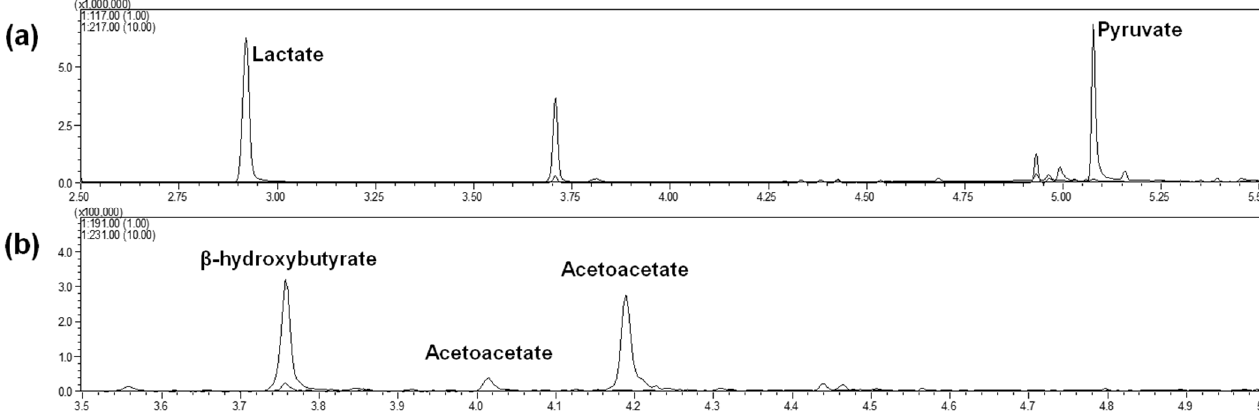
Figure 2. ( a ) Mass chromatograms of a rat liver sample for lactate ( m / z 117) and pyruvate ( m / z 217) (tube 1). The concentrations were 1.23 mM and 0.18 mM, for lactate and pyruvate, respectively. Note that an additional peak can be observed at 3.7 min, derived from the elution of β -hydroxybutyrate, which was stable against the MAD quinoxalinol derivatization step. ( b ) Mass chromatograms of a rat liver sample for β -hydroxybutyrate ( m / z 191) and acetoacetate ( m / z 231) (tube 2). The concentrations were 0.56 mM and 0.031 mM, for β -hydroxybutyrate and acetoacetate, respectively. Table 1. Selected ion monitoring values ( m / z ) and retention time of metabolites. TMS: